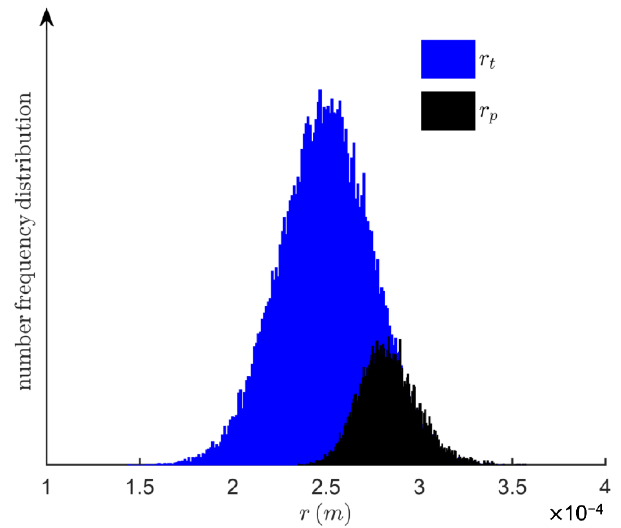
Figure 1. Pore and throat radius distribution for the random network with throat mean radius 250 µm and the standard deviation 25 µm. The pore radius is assumed larger or at least equal with the largest radius of neighbor throats.